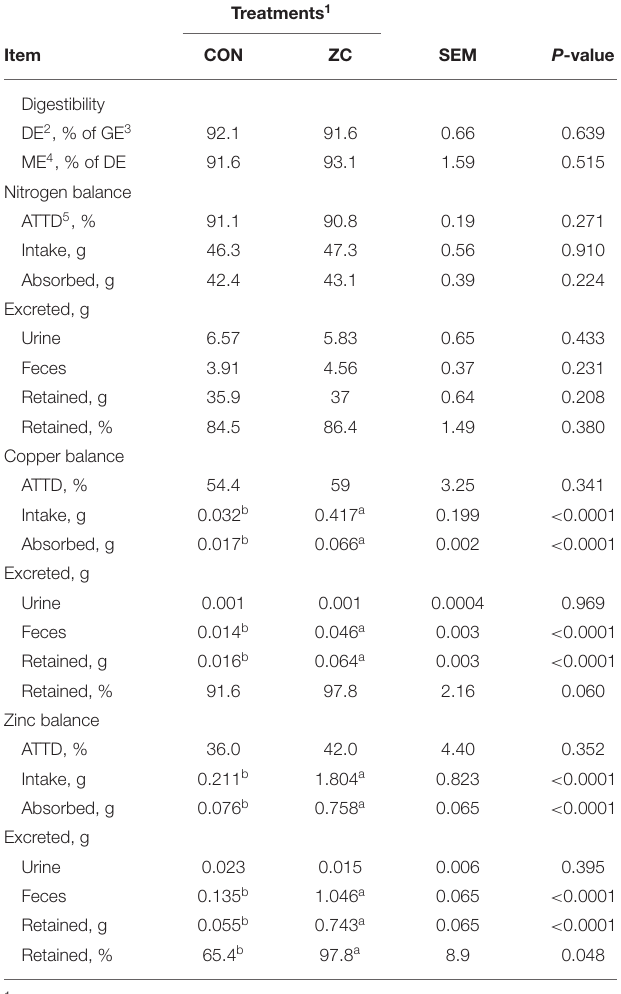
TABLE 6 | Energy digestibility, mineral digestibility, and Nitrogen balance of pigs fed a control diet (CON) vs. pigs fed a diet containing pharmacological levels of Zn and Cu (ZC) (Expt.